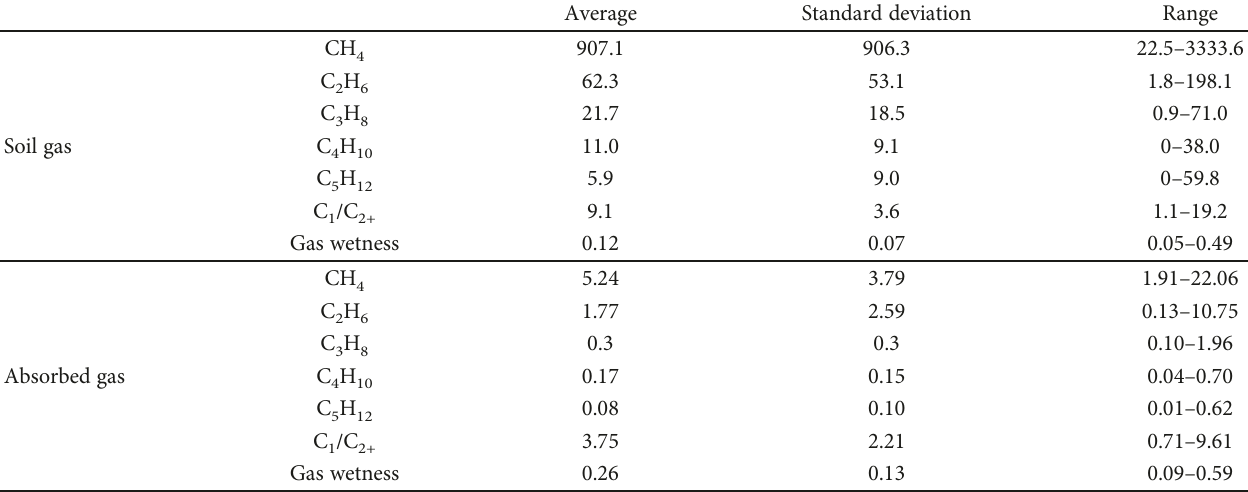
Table 3: Gas concentration analyses of soil gas and absorbed gas in Dawanqi oil fi eld. Average Standard deviation Range